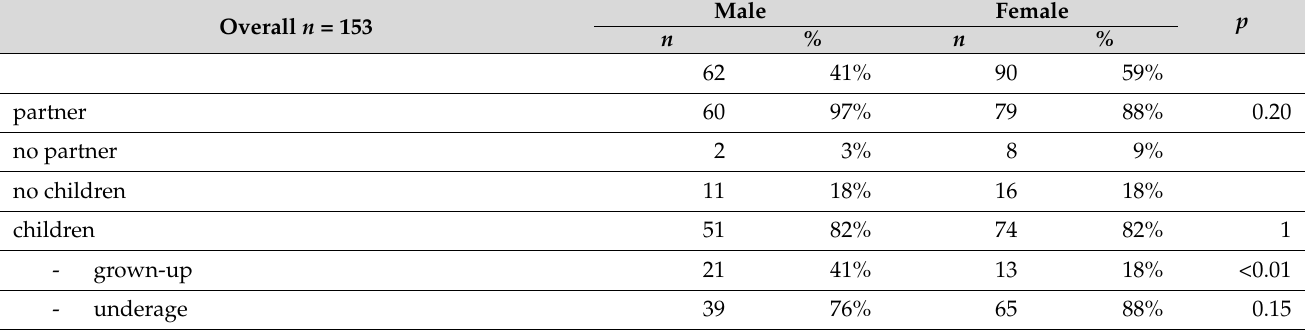
Figure 1. Age groups of the respondents (for both genders). Table 1. Basic parameters of the